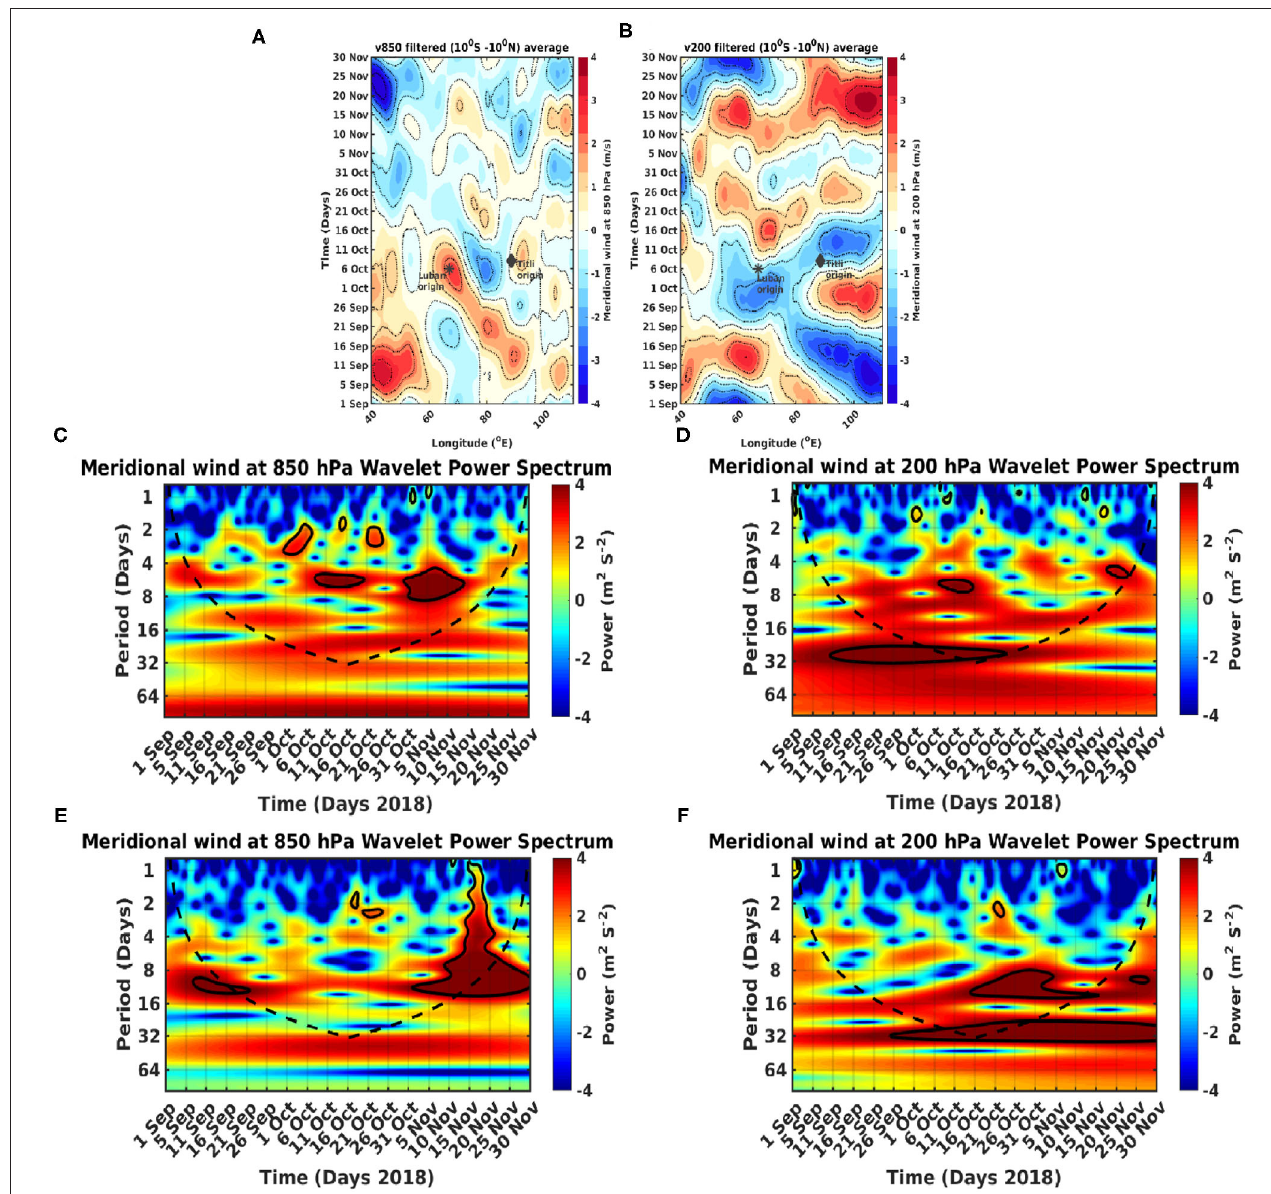
FIGURE 12 | A time-longitude Hovmöller diagram of filtered meridional wind (m/s) at 850 hPa (A) and 200 hPa (B) averaged over 10 ◦ S to 10 ◦ N from September 1 to November 30, 2018. Black asterisk and diamond symbols show the origin of cyclones Luban and Titli, respectively. Wavelet power spectrum analysis of meridional wind (m 2 s − 2 ) at 850 hPa (C,E) and 200 hPa (D,F) at the origin of cyclones Luban and Titli from September 1 to November 30, 2018. The black broken line represents the cone of influence, and, beyond that line, wavelet power can be distorted (less reliable). The black solid contoured regions show the power, which is 95% significant.